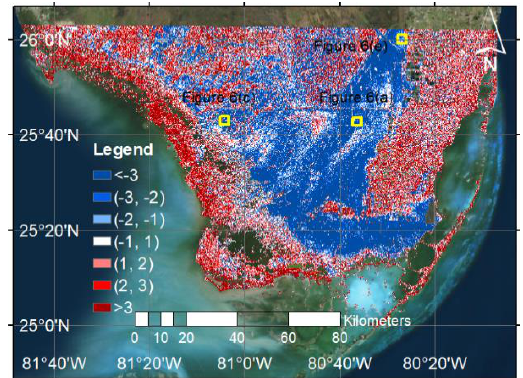
Figure 5. Normalized scattering change values mapped according to the detection confidence. Blue pixels show detected scattering decrease, red pixel show detected increase, and white pixel indicates the change is not significant, i.e. non- flooded or undetectable. The shades of blue and red mark the detection confidence, as presented in Table 3. Yellow frames mark the zoomed-in areas presented in Figure 6.